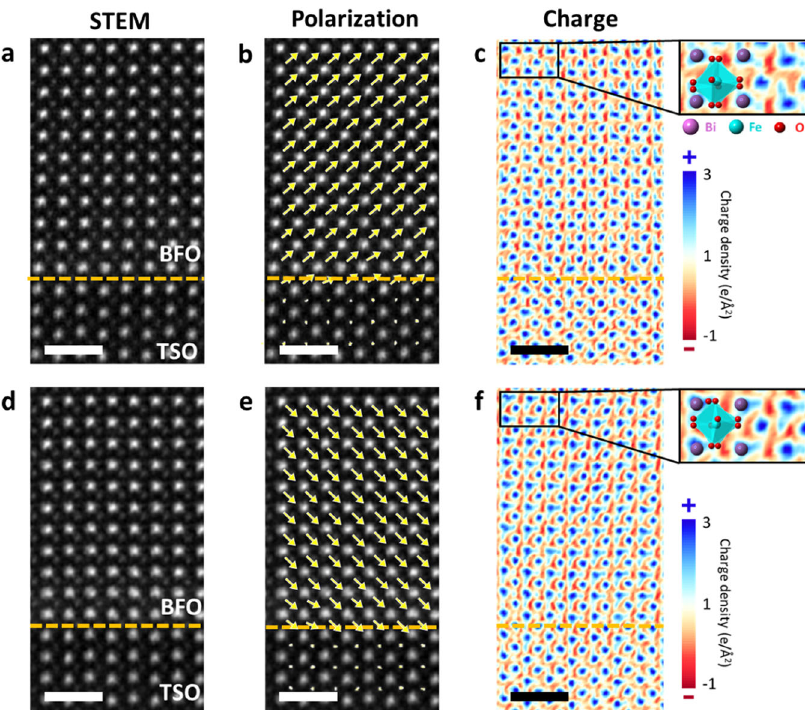
Fig. 2 Polarization and charge density maps. a – c An atomically resolved HAADF STEM image of an upward polarized domain at the interface from the region marked by the white rectangle e in Fig. 1b (a) and corresponding maps of − D FB vectors overlaid on the same HAADF STEM image ( b ) and charge density with atomic model overlaid ( c ). d – f An atomically resolved HAADF STEM image of downward polarized domain at the interface from the region marked by the white rectangle d in Fig. 1b (d) and corresponding maps of − D FB vectors overlaid on the same HAADF image ( e ) and charge density with atomic model overlaid ( f ). The HAADF STEM images and charge density maps are acquired separately. Scale bar, 1